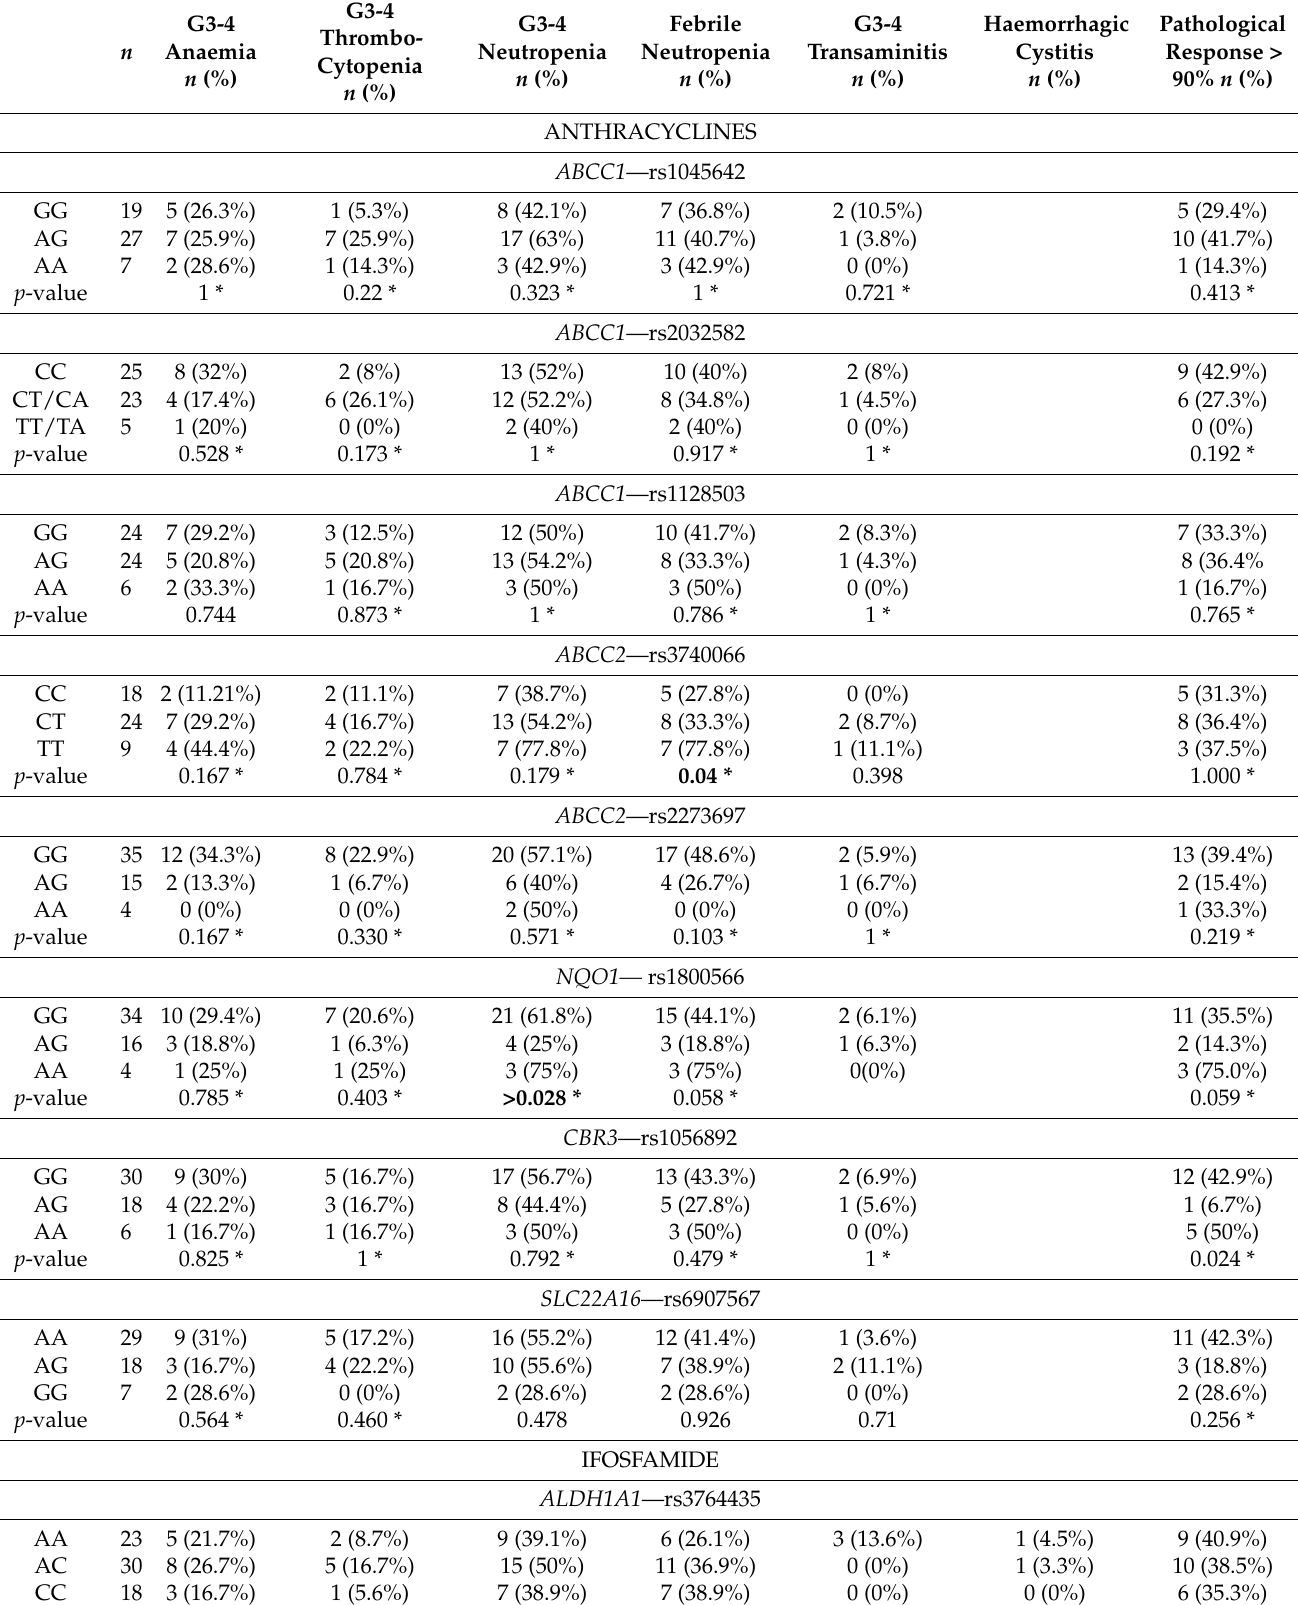
Table 3. Univariate associations between genetic variants and toxicities and pathological